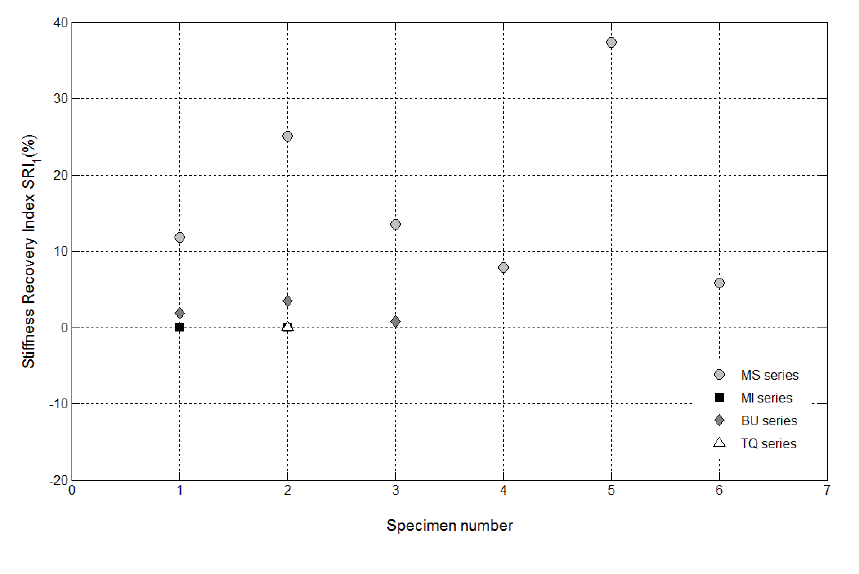
Figure 15. Stiffness recovery indices SRI 1 for control specimens (Samples 1 and 2 belonging to the MI series and Sample 2 belonging to the TQ series) and self-healing specimens (Samples 1–6 belonging to the MS series and Samples 1–3 belonging to the BU